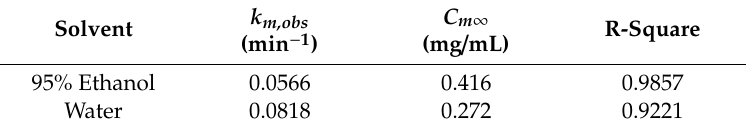
Table 3. Correlated values of k m,obs and C m∞ of myricitrin in the solvent.